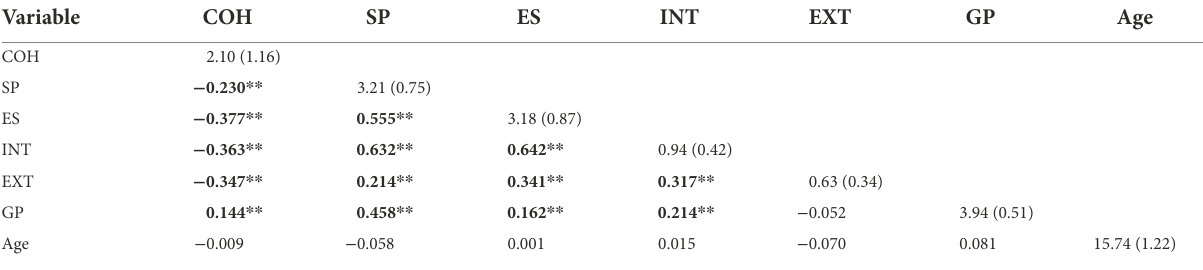
TABLE 2 Intercorrelations, means, and standard deviations of the final sample.